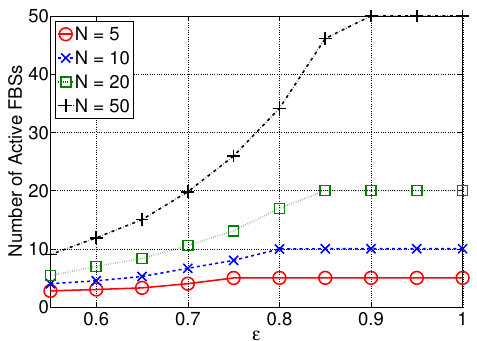
Figure 4. Number of active FBSs vs. (cid:101) by varying N